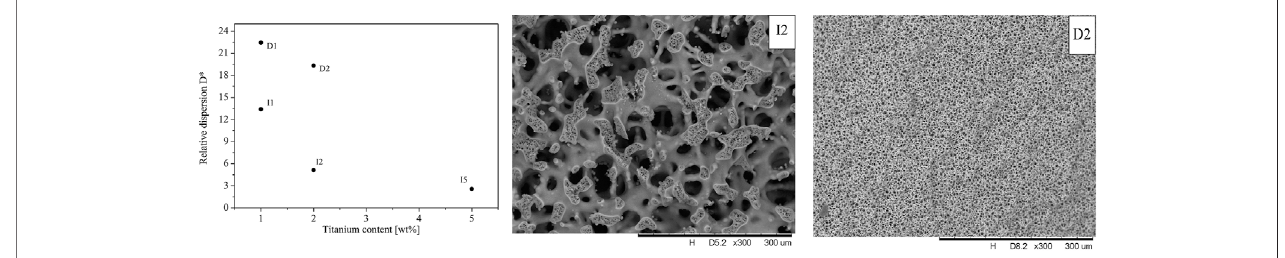
FIGURE 3 | Relative dispersion vs . Ti content and SEM image of the macroporous structure of I2 and D2 monoliths.